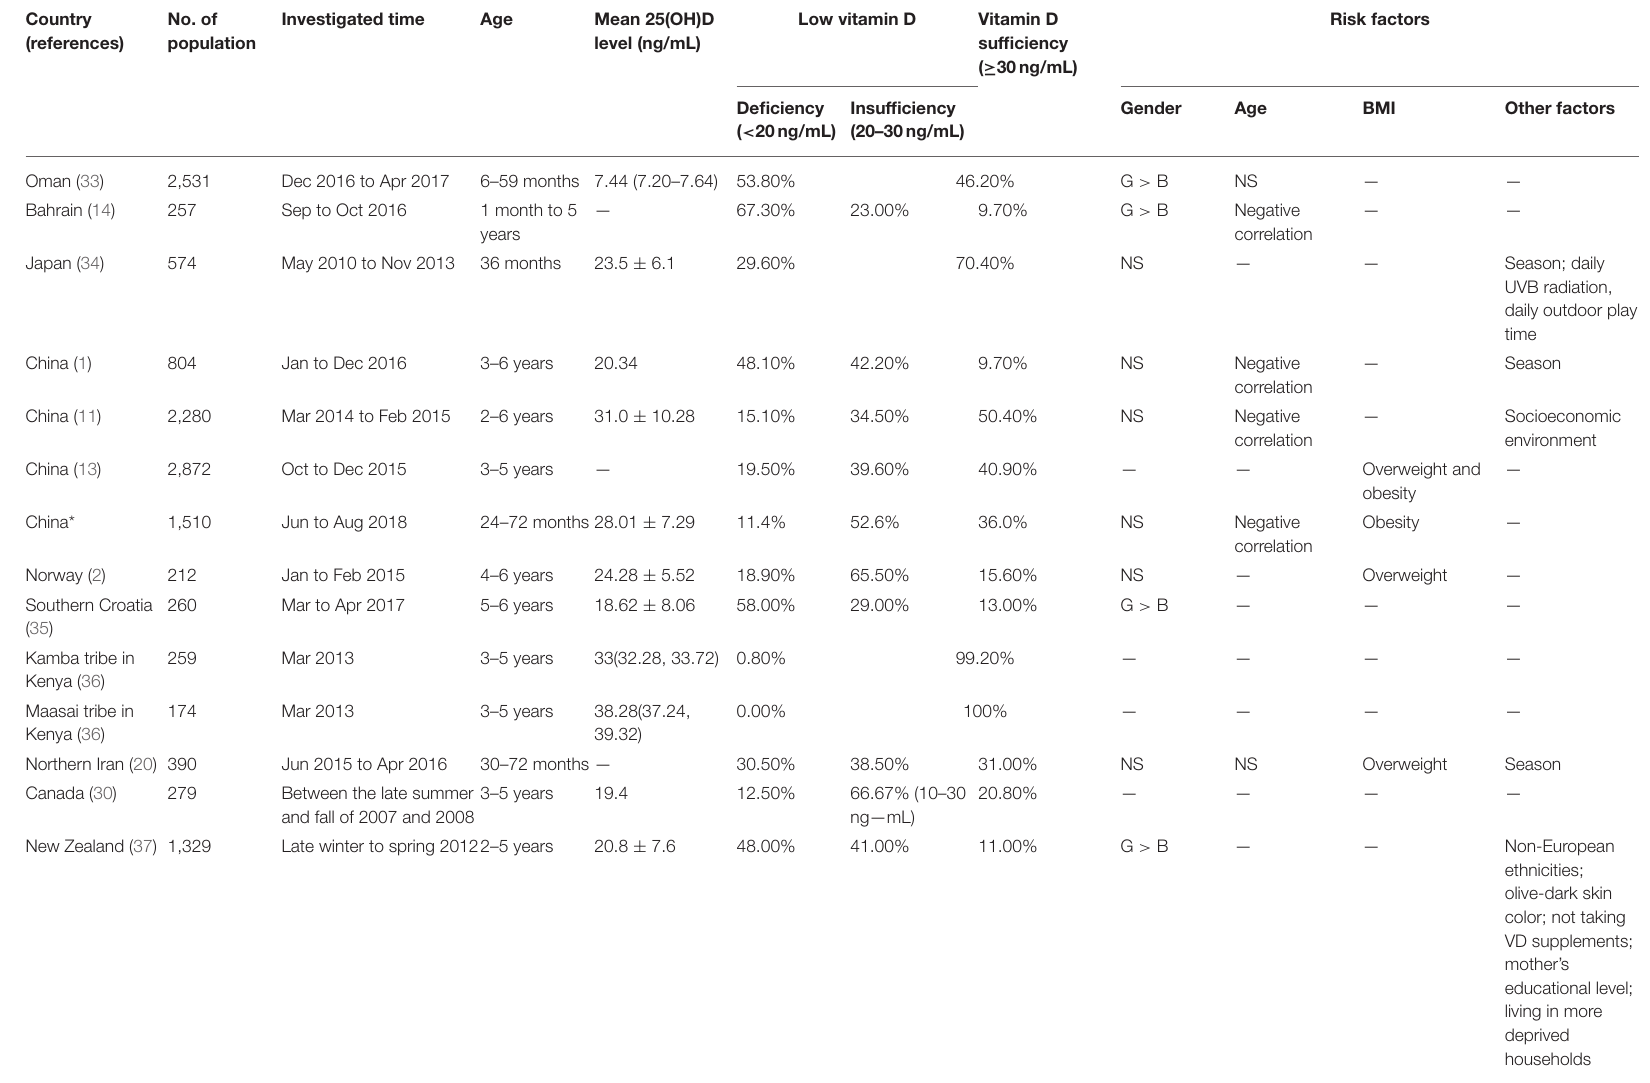
TABLE 3 | Prevalence and risk factors for low vitamin D (vitamin D deficiency and insufficiency) in preschool children worldwide. Country